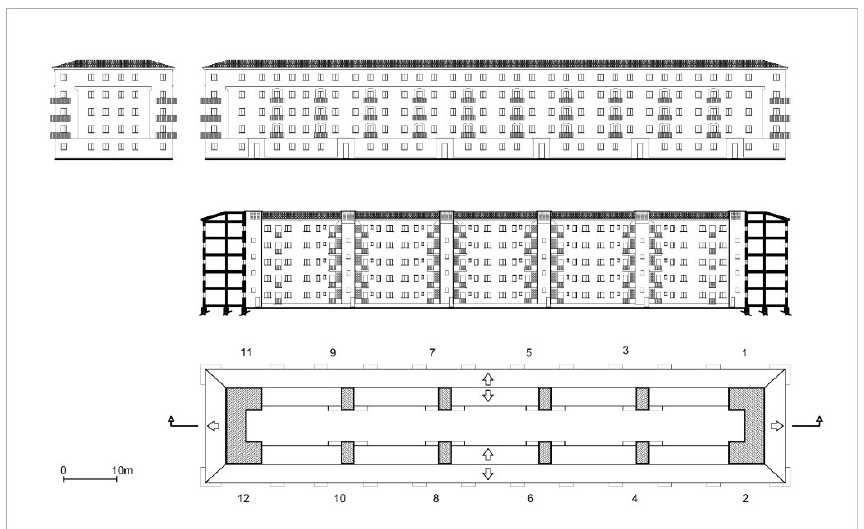
Figure 4. Front side view, side elevation, section and roof plans